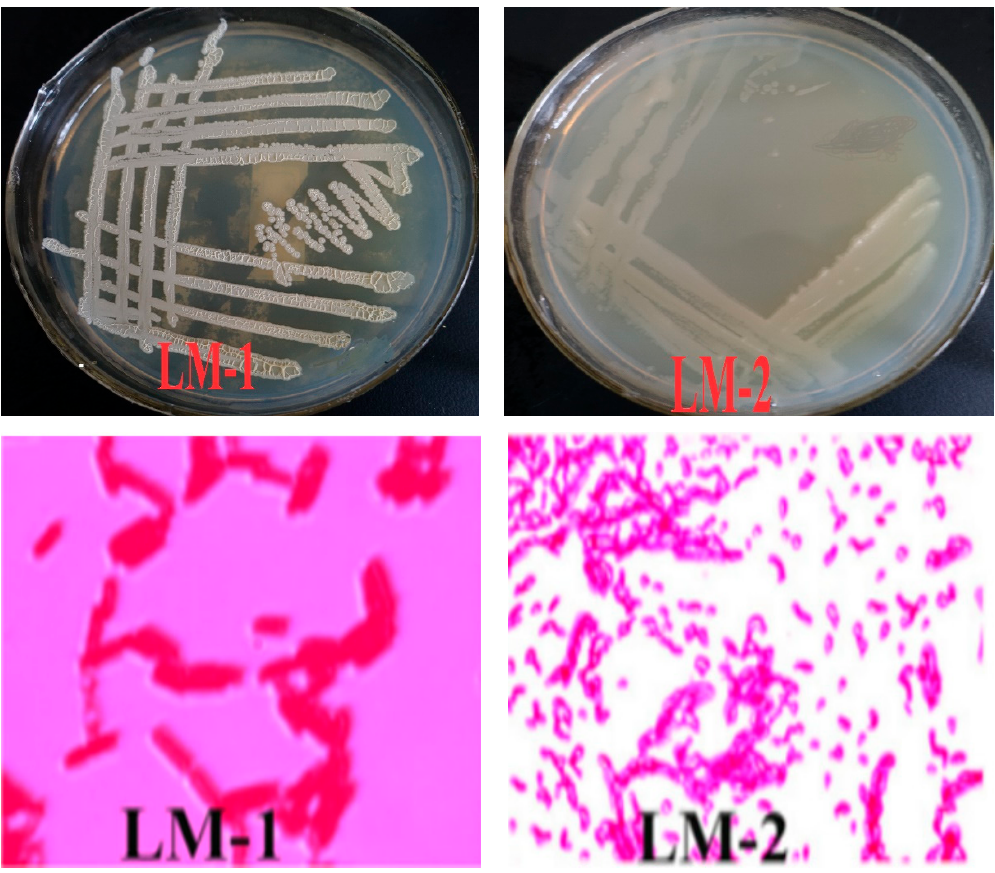
Figure 2. Individual forms of bacterial isolates of LM-1 and LM-2.